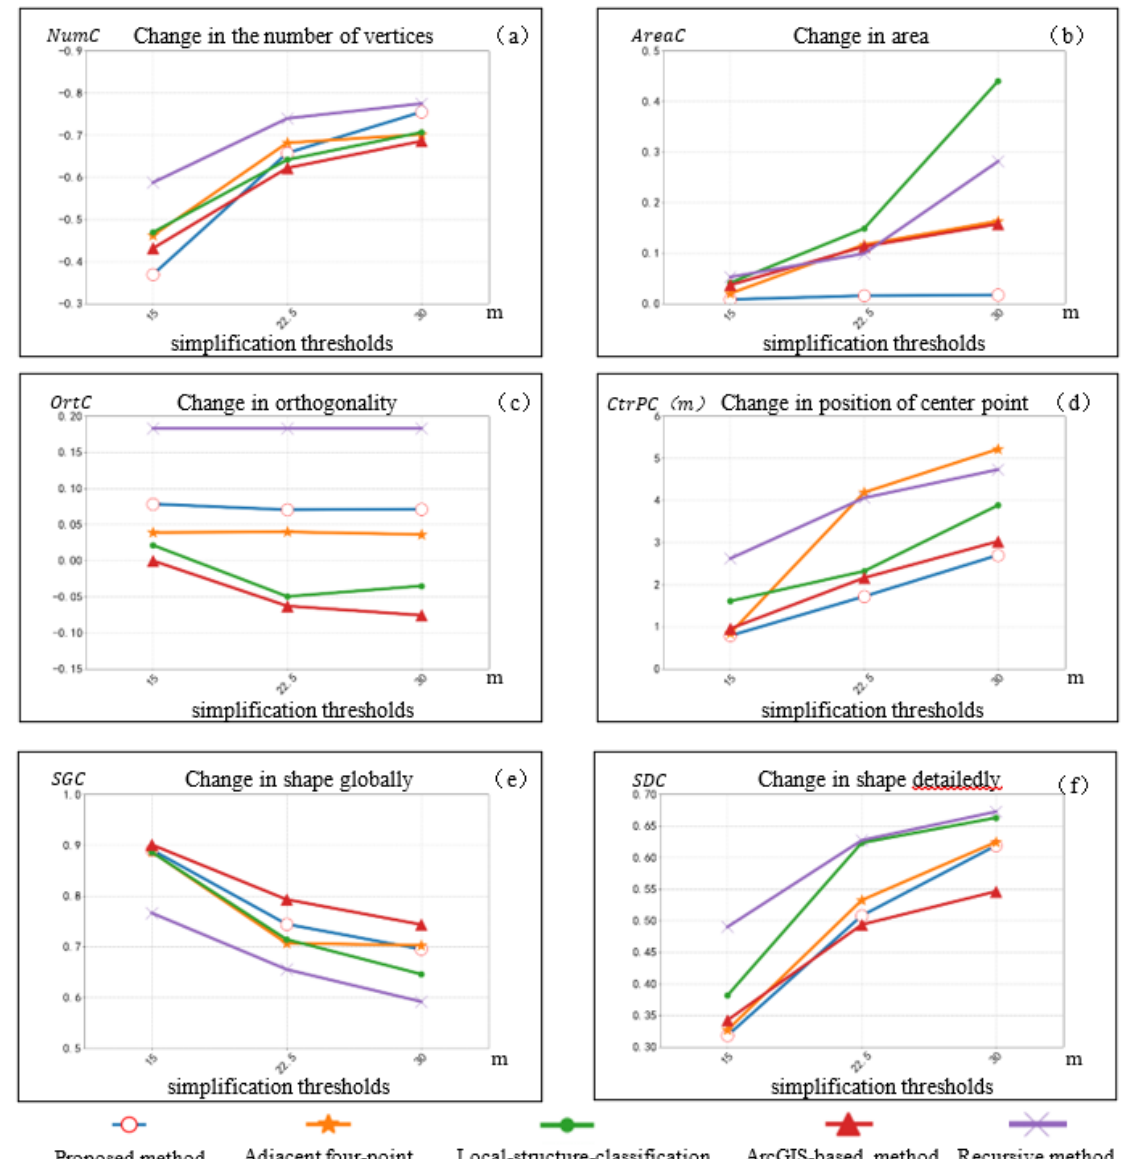
Figure 17. Comparison of simplification methods at different thresholds: ( a ) NumC , ( b ) AreaC , ( c ) OrtC , ( d ) CtrPC , ( e ) SGC , ( f ) SDC .